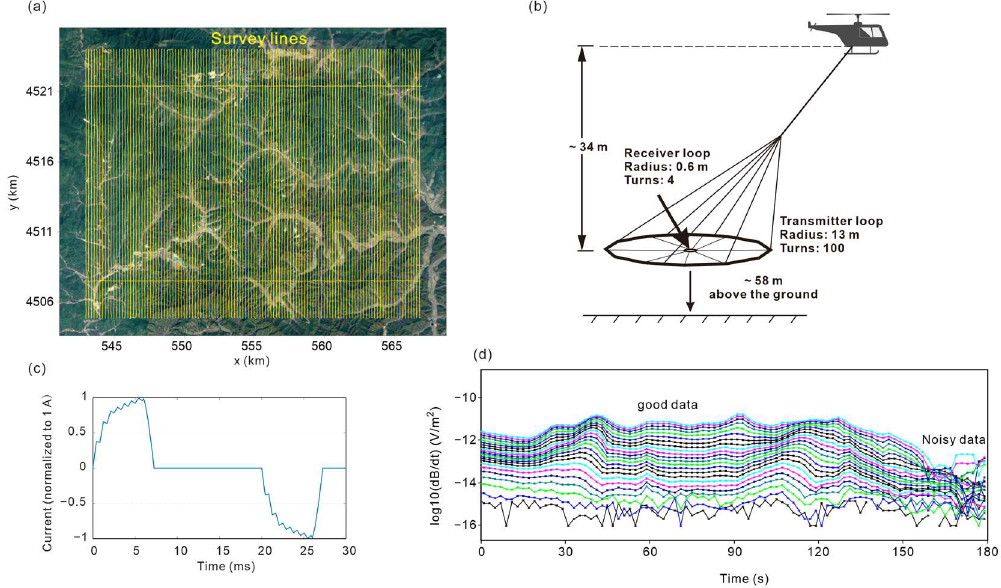
Figure 3. Data acquisition in Qingchengzi survey area. ( a ) Flight-line map over a satellite image. The yellow lines represent the position of the VTEM survey line, including 120 survey lines in the north-south direction and 2 survey lines in the east-west direction. ( b ) Configuration for ATEM method at Qingchengzi. ( c ) VTEM transmitter current waveform. ( d ) Typical VTEM raw data (plotted every two channels).